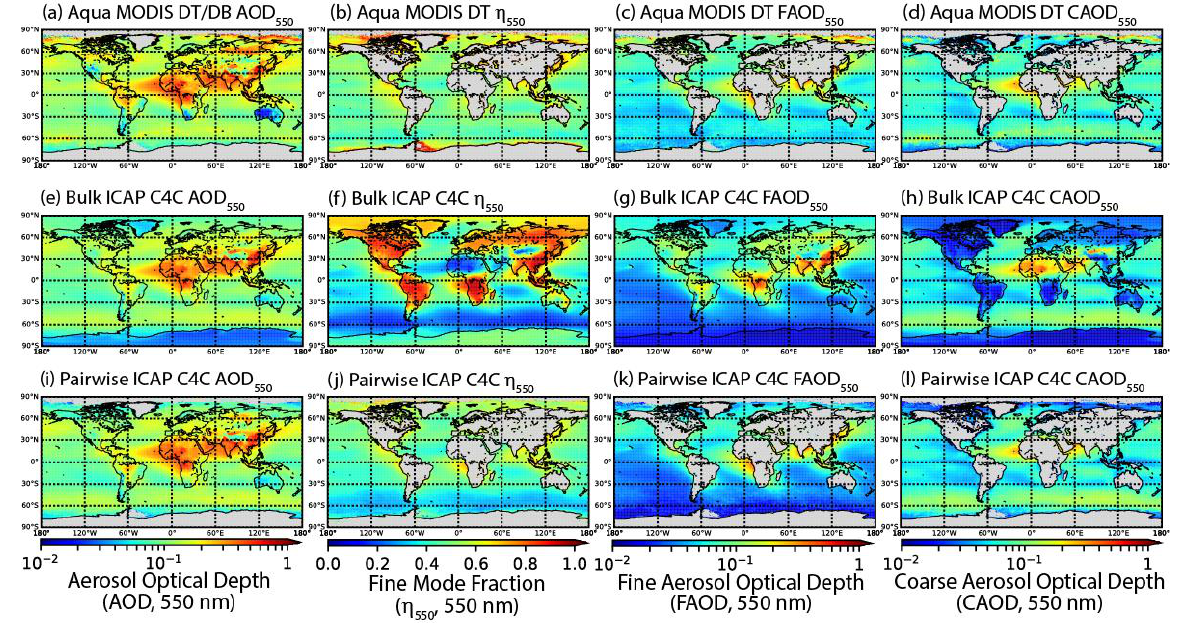
Figure 2. Four-year average (2016 – 2019) comparisons of 550 nm, Aerosol Optical Depth (AOD 550 ), Fine Mode Fraction (η 550 ), Fine mode Aerosol Optical Depth (FAOD 550 ), and Coarse mode Aerosol Optical depth (CAOD 550 ). Included are: ( a – d ) Combined Aqua MODIS Dark Target/Deep Blue AOD 550 and Aqua MODIS Dark Target η 550 , FAOD 550 , and CAOD 550 . ( e – h ) Corresponding bulk total average AOD products from the ICAP Core Four Consensus (C4C). ( i – l ) Average AOD products from the C4C for only those data with a corresponding Aqua MODIS retrieval.